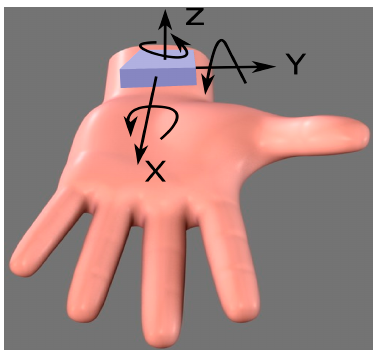
Figure 4. Accelerometer and gyroscope axes (positive direction) for the hand module.